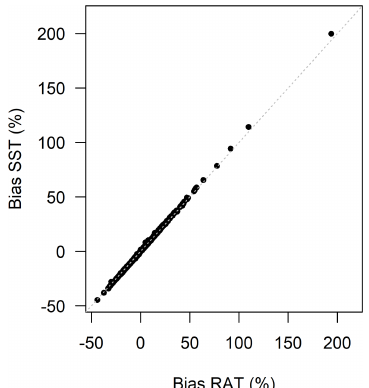
Figure A2. Comparison of the annual bias obtained with the RAT with the annual bias obtained with the leave-one-out SST. Each of the 21 catchments is represented with annual bias values (47 points by catchment, 21 × 47 points in